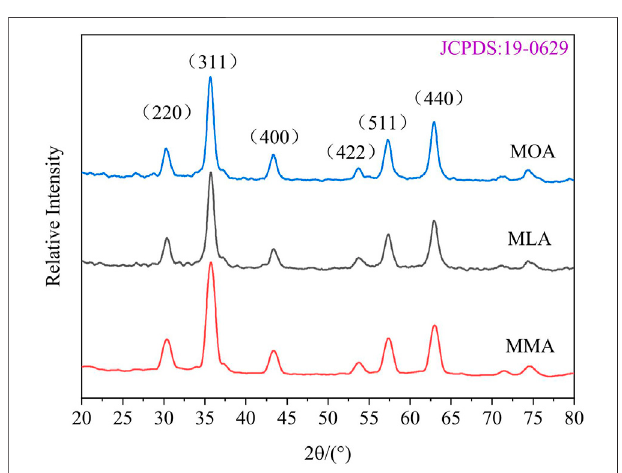
FIGURE 2 | XRD images of Fe 3 O 4 particles in three magnetic fl